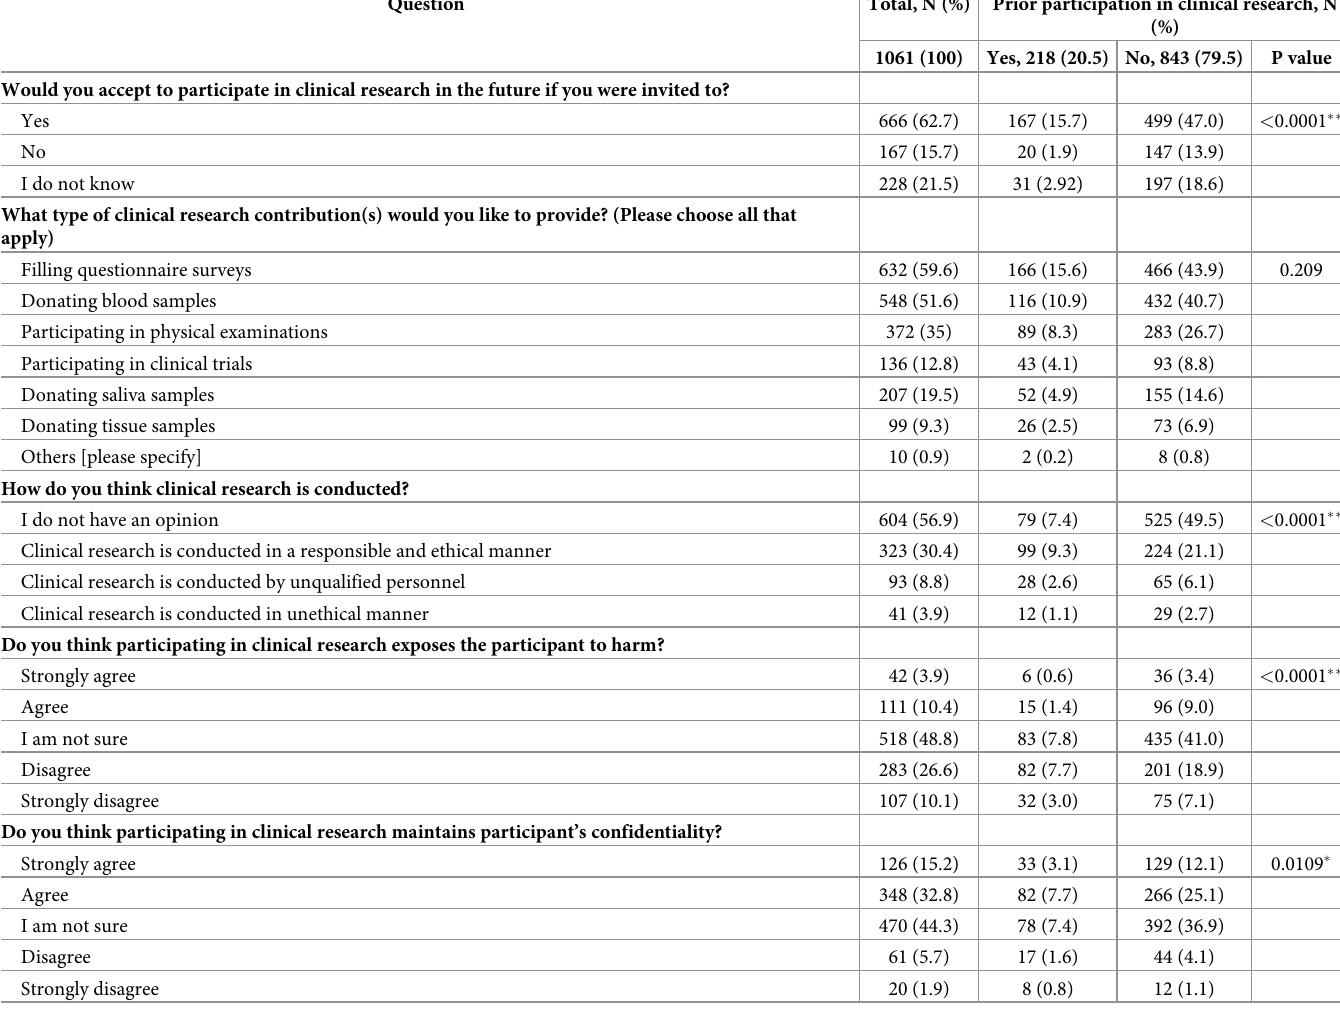
Table 2. Cross tabulation of prior clinical research participation with future participation, contribution interests, and attitudes towards clinical research conduct, confidentiality, and